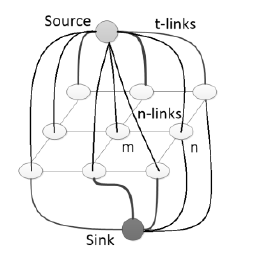
Figure 2. A graph with two terminal nodes